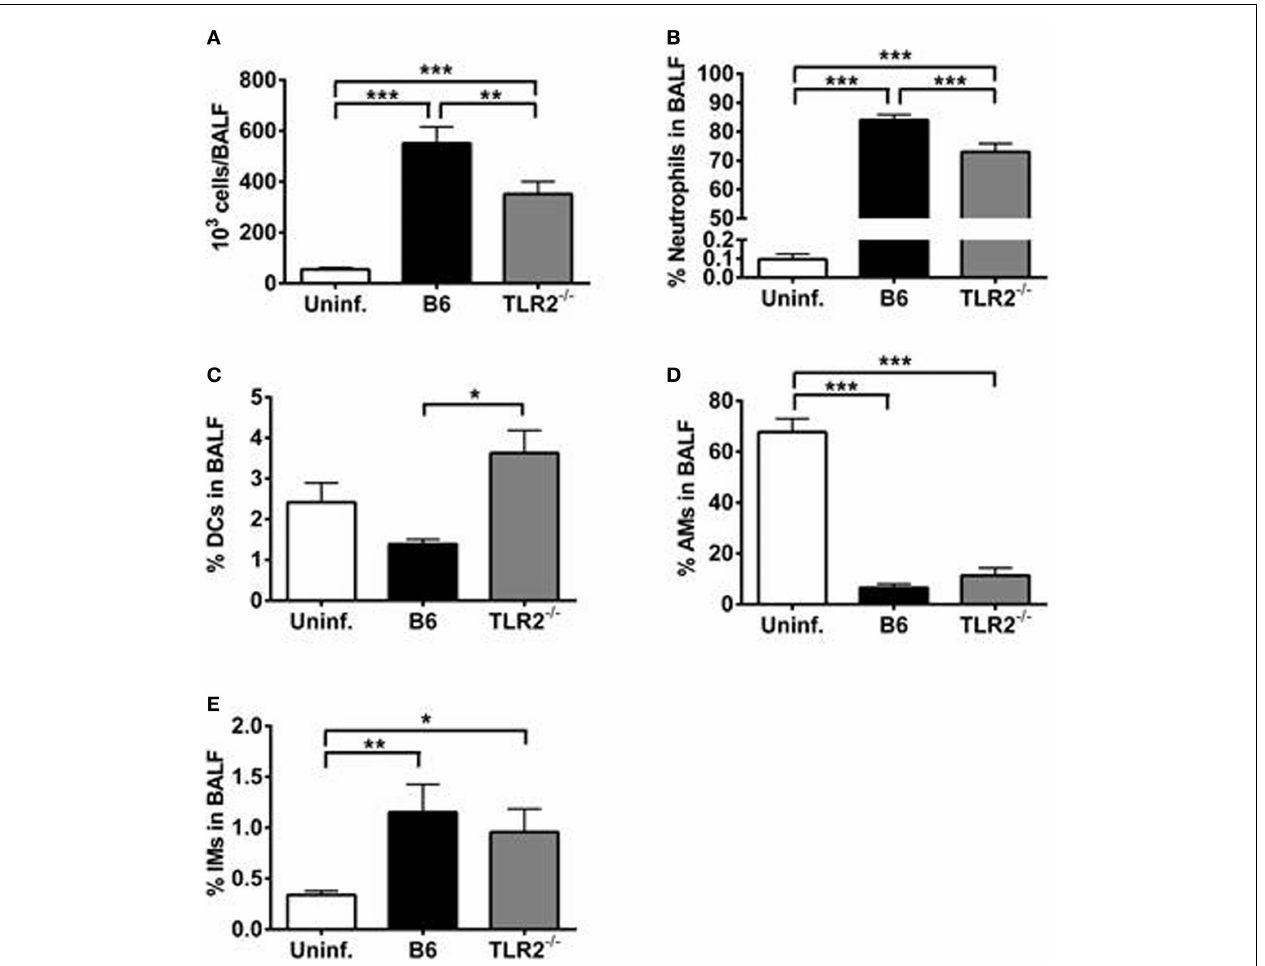
(B) neutrophils, (C) dendritic cells (DCs), (D) alveolar macrophages (AMs), and (E) interstitial macrophages (IMs) in the BALF was determined using flow cytometry. Data are combined from two independent experiments. n = 7–12 mice/group. Statistical significance was determined using ANOVA with Tukey’s